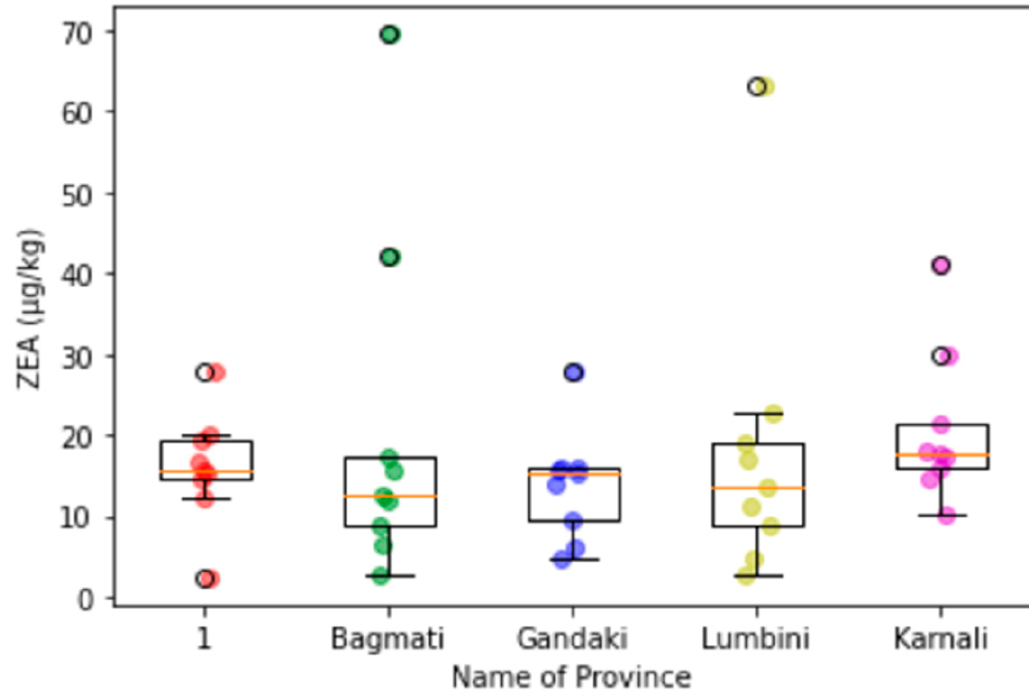
Figure A8. Contamination level of ZEA.